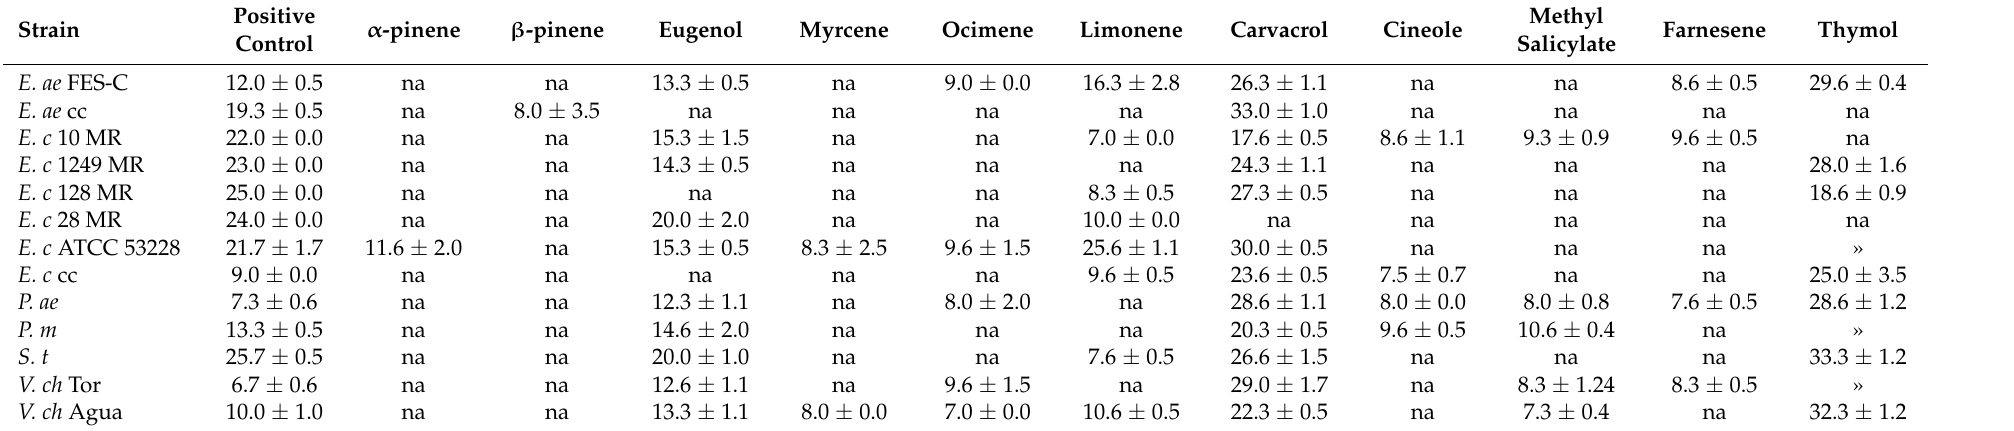
Table 2. Antimicrobial activity of some compounds in Gram-negative